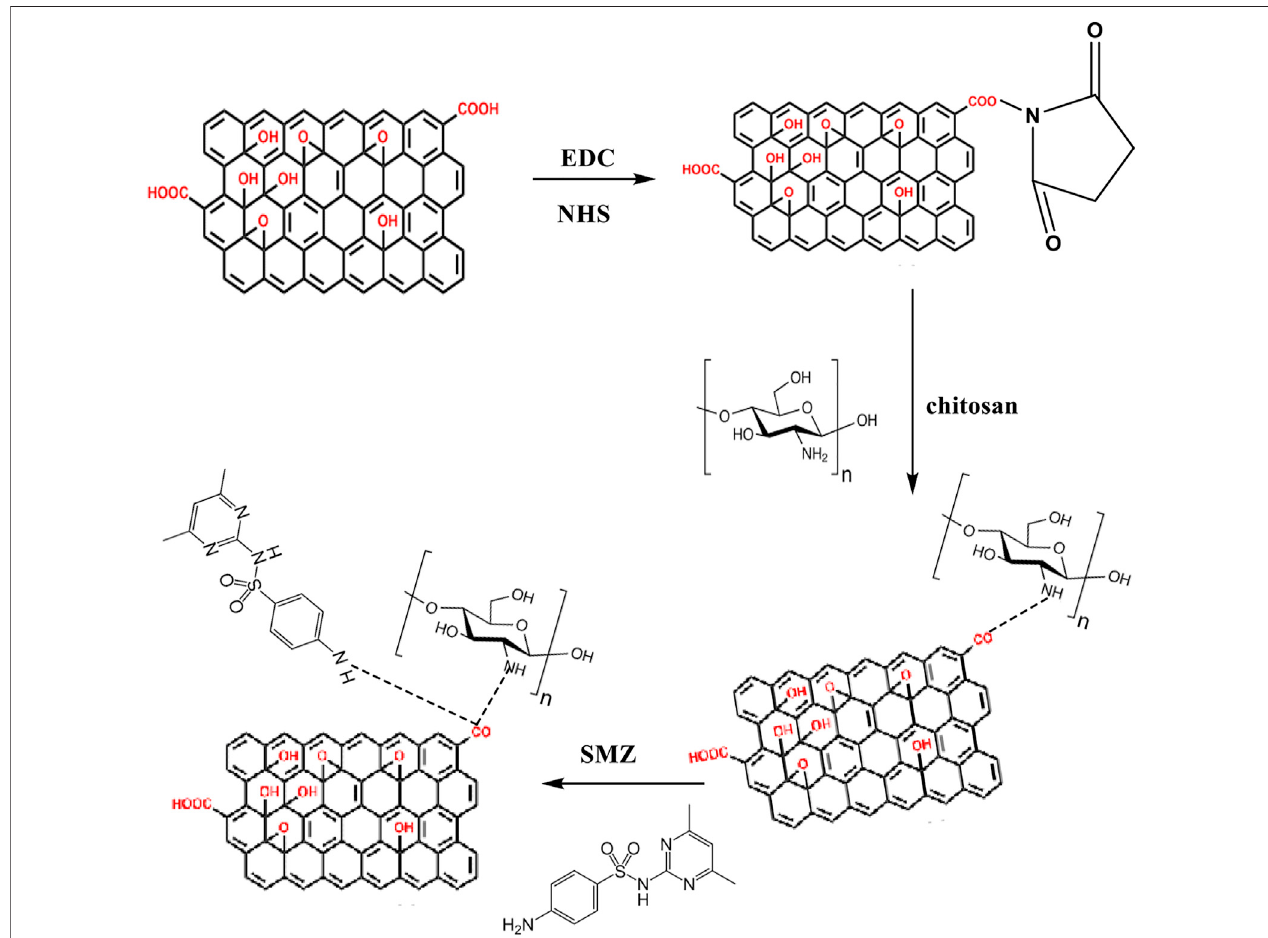
SCHEME 1 | Synthesis of 3D